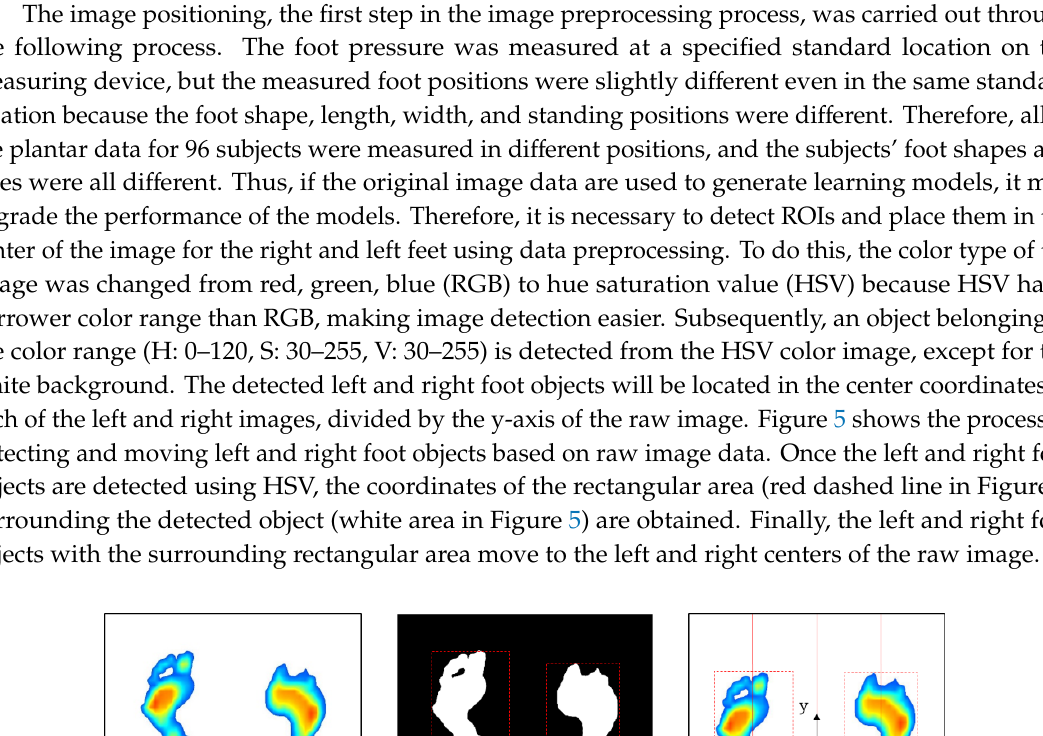
Figure 4. Image data pre-processing.